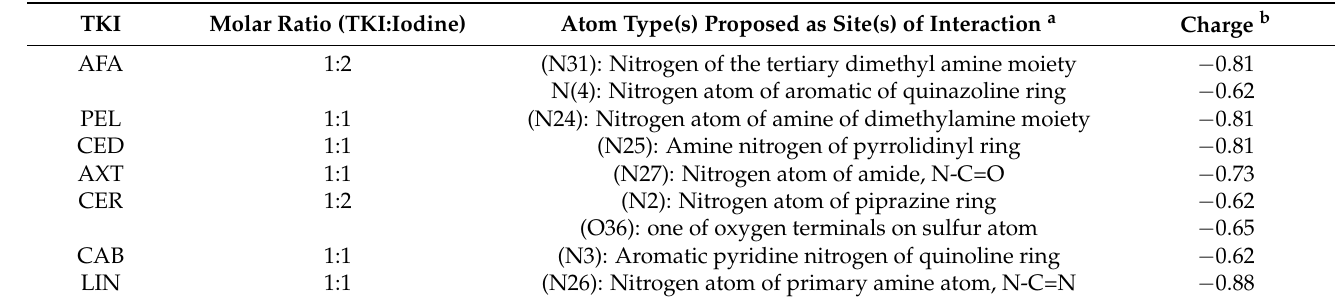
Table 4. The molar ratios of the reaction of TKIs with iodine, types of atoms proposed site(s) of interaction on TKIs molecules and charges on these atoms.